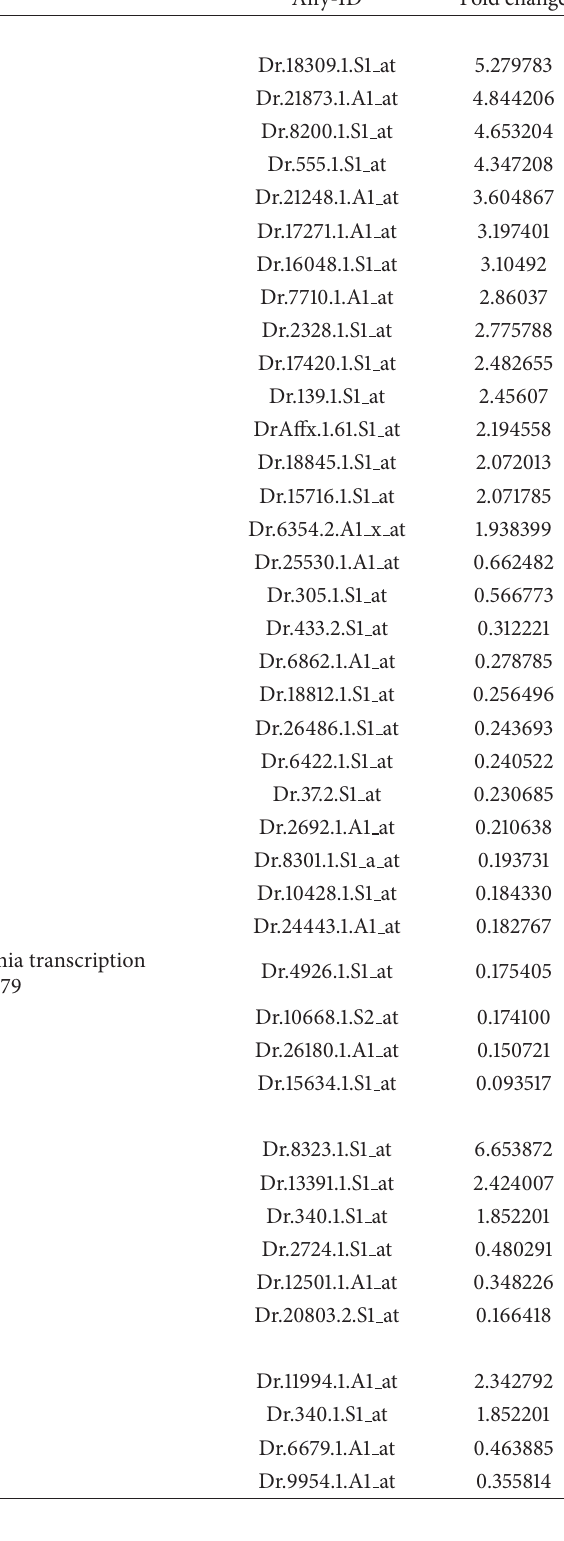
Table 6: Differentially expressed genes involved in nucleic acid metabolism in the muscle of crisp grass carp and grass